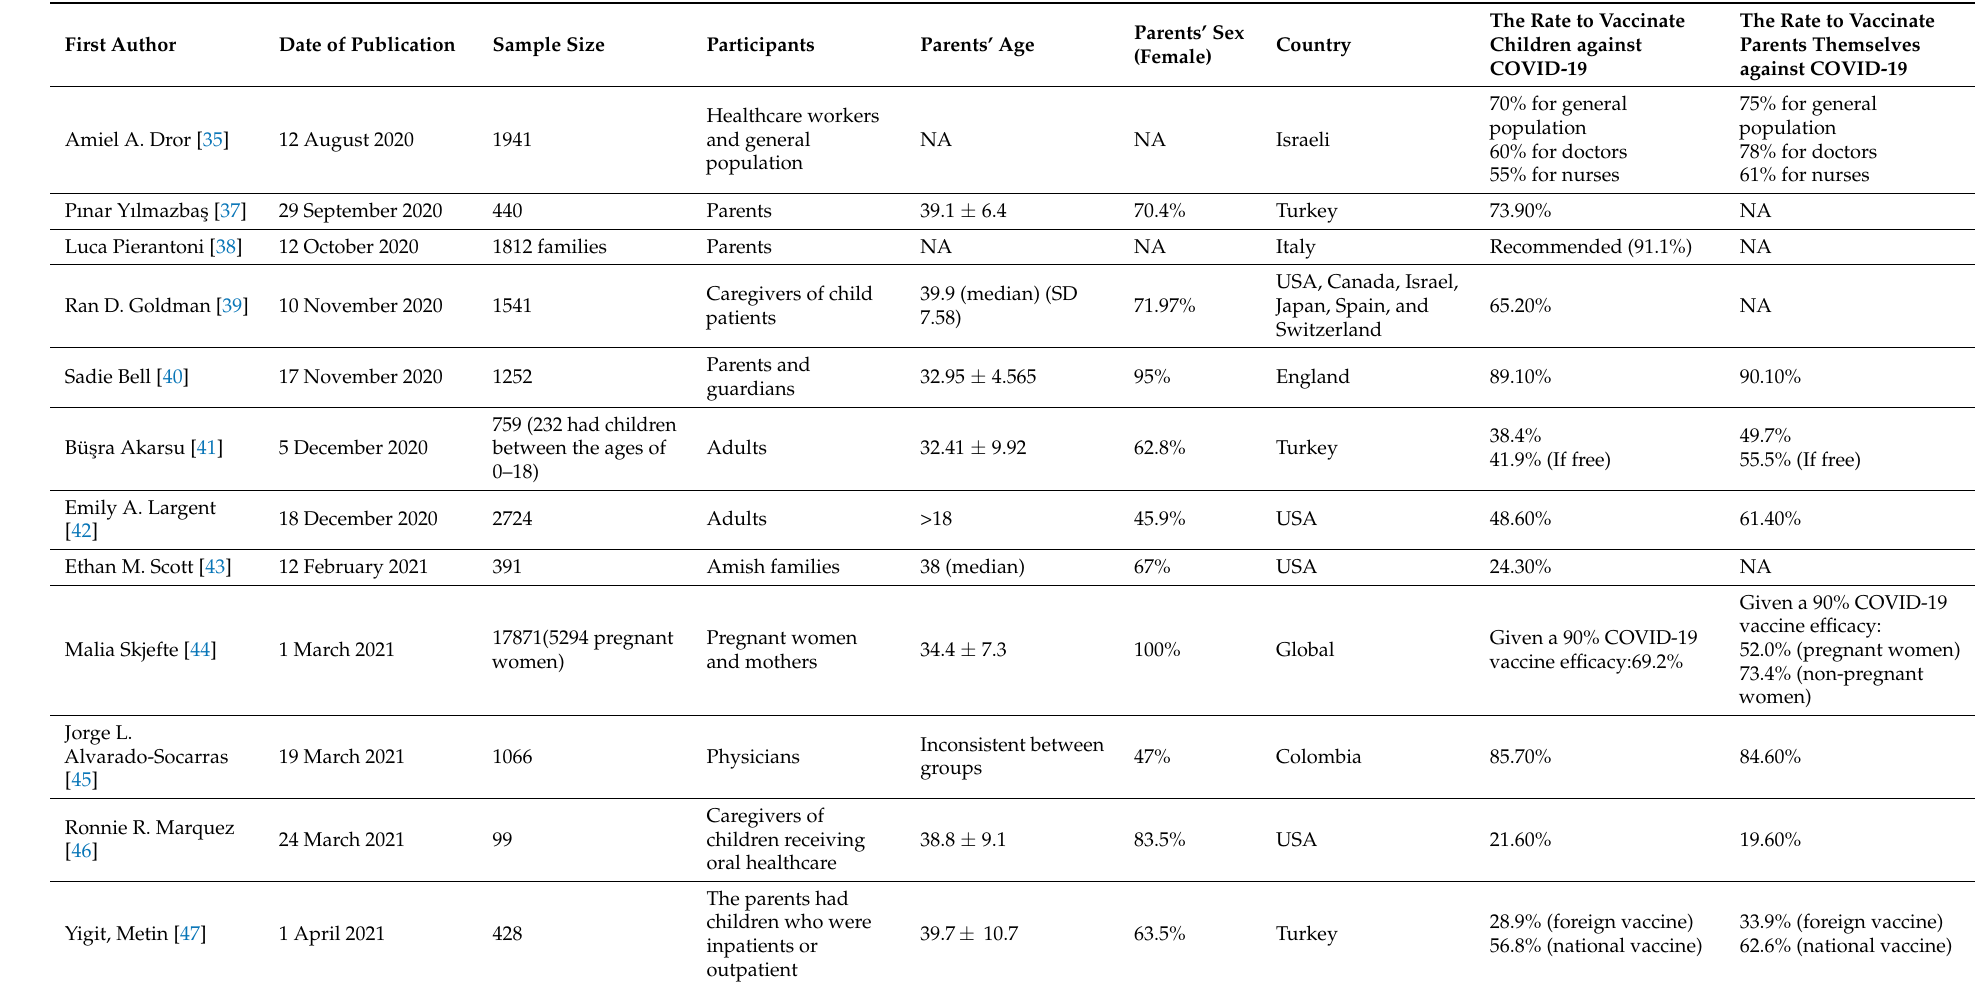
Table 2. Characteristic of